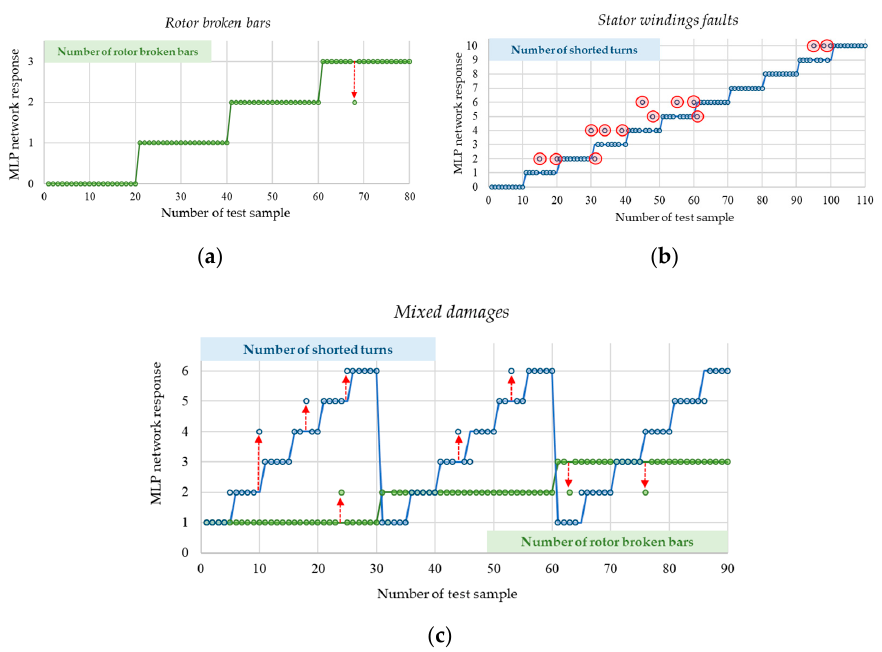
Figure 9. The results of experimental tests: ( a ) detection of rotor damage; ( b ) detection of stator damage; ( c ) detection of mixed faults.